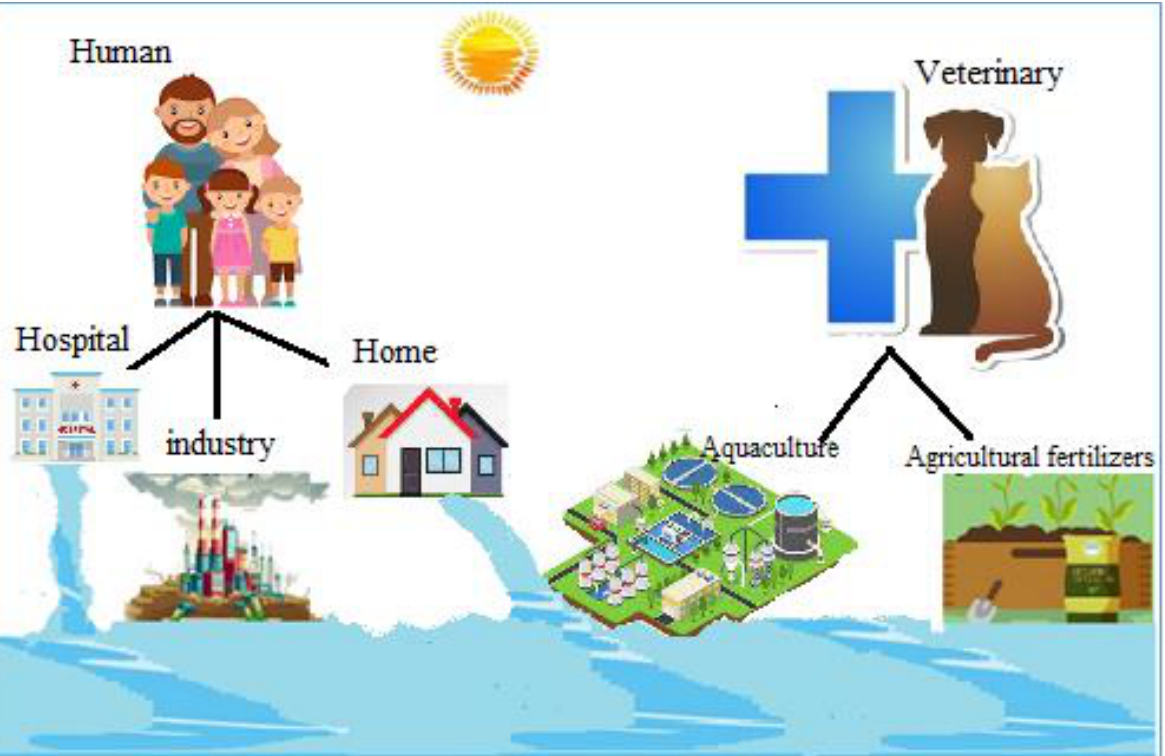
Figure 2. Means of entry of antibiotics into aquatic environments.